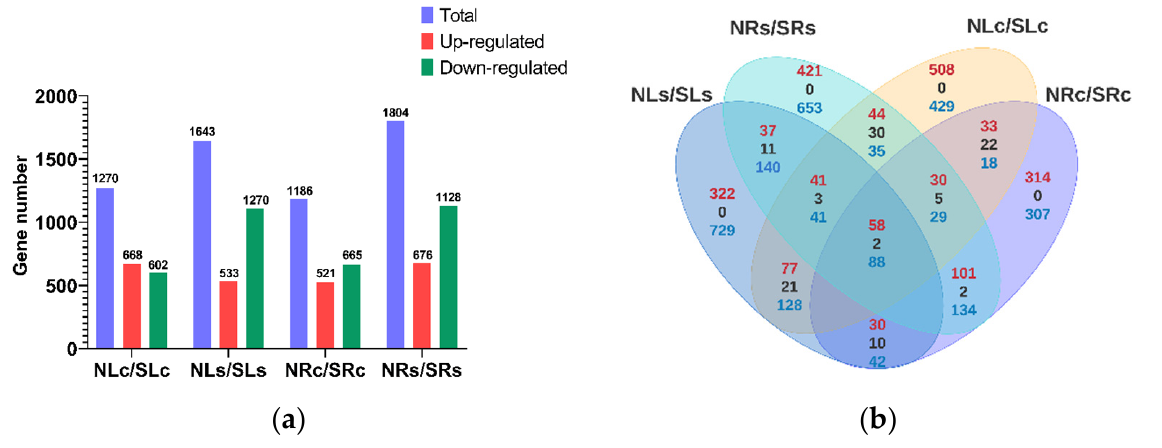
Figure 4. Number of DEGs: ( a ) DEGs in the four comparative combinations of Nampungchal and Sodamchal in the leaves and roots under salt-stress and control conditions and ( b ) distribution of overlapping or unique genes identified by Venn diagram. NL(R)c, Nampungchal leaves (roots) control; SL(R)c, Sodamchal leaves (roots) control; NL(R)s, Nampungchal leaves’ (roots’) salt-stress; SL(R)s, Sodamchal leaves’ (roots’) salt-stress. Number in red is number of upregulated genes, number in black is number of contra-regulated genes, and number in blue letter is number of downregulated genes.